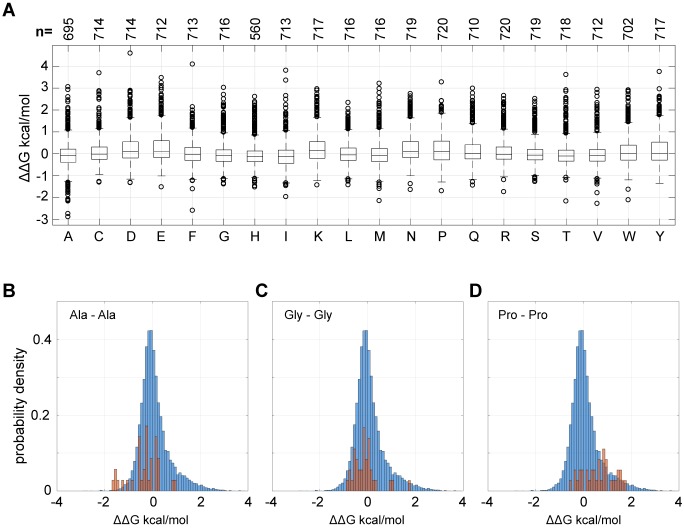
Amino acid contributions to distributions of double mutant cycle coupling energies for the PDZ α2 helix.(A), Boxplots showing the couplings for each amino acid substitution with every other amino acid substitution in the homolog-averaged dataset. The data show that every amino acid substitution is involved in essentially the full range of observed couplings, and mean couplings for each mutation is near zero. These findings indicate that the magnitude of couplings is not a simple property of the average chemical properties of different amino acids, and that mutations on average are subtle perturbations to protein function. (B–D), Each graph shows the distribution of pairwise thermodynamic couplings for all pairs of positions in the homolog-averaged dataset (blue), with couplings for Ala – Ala (B), Gly – Gly (C), and Pro – Pro (D) mutations highlighted in red. The data suggest a broad range of couplings for all these substitutions, arguing that the magnitude of coupling energies is not obviously defined by intuitive classifications of mutations expected to be subtle (Ala) and mutations expected to be disruptive for the α2 helix (Gly, Pro).